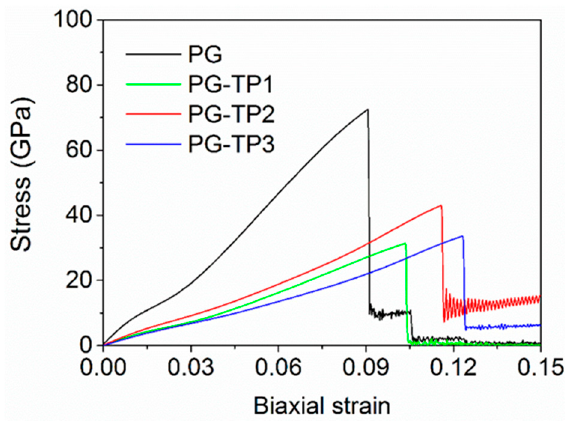
Figure 3. Stress–strain curves obtained from biaxial tensile tests. Table 1. Mechanical parameters of PG-TPX sheets after uniaxial and biaxial tensions.